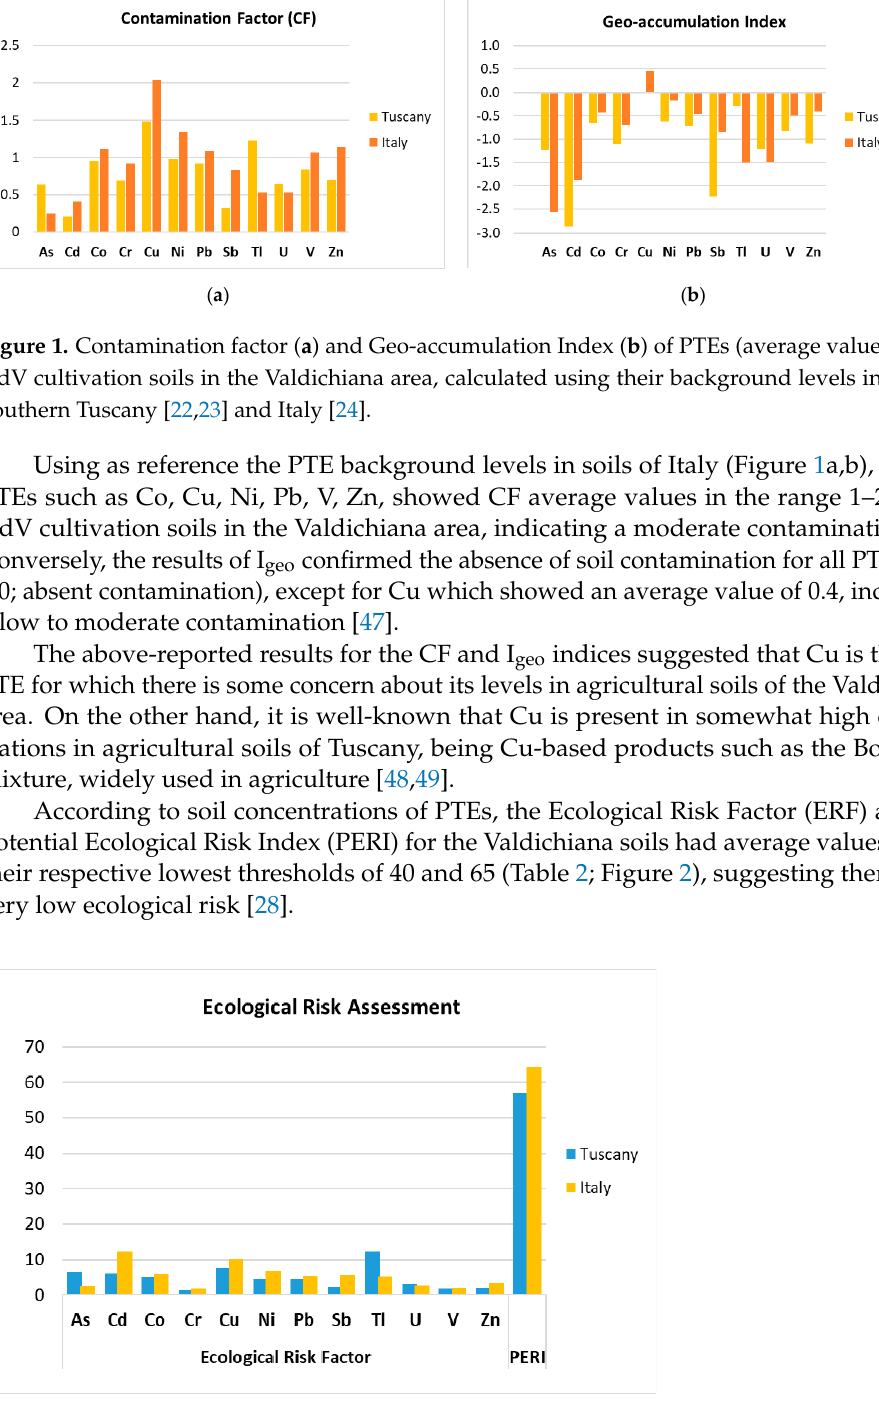
Figure 2. Average values of the Ecological Risk Factor (ERF) and Potential Ecological Risk Index (PERI) related to the concentrations of PTEs in AdV cultivation soils in the Valdichiana area and PTE background levels in soils of Southern Tuscany and Italy.